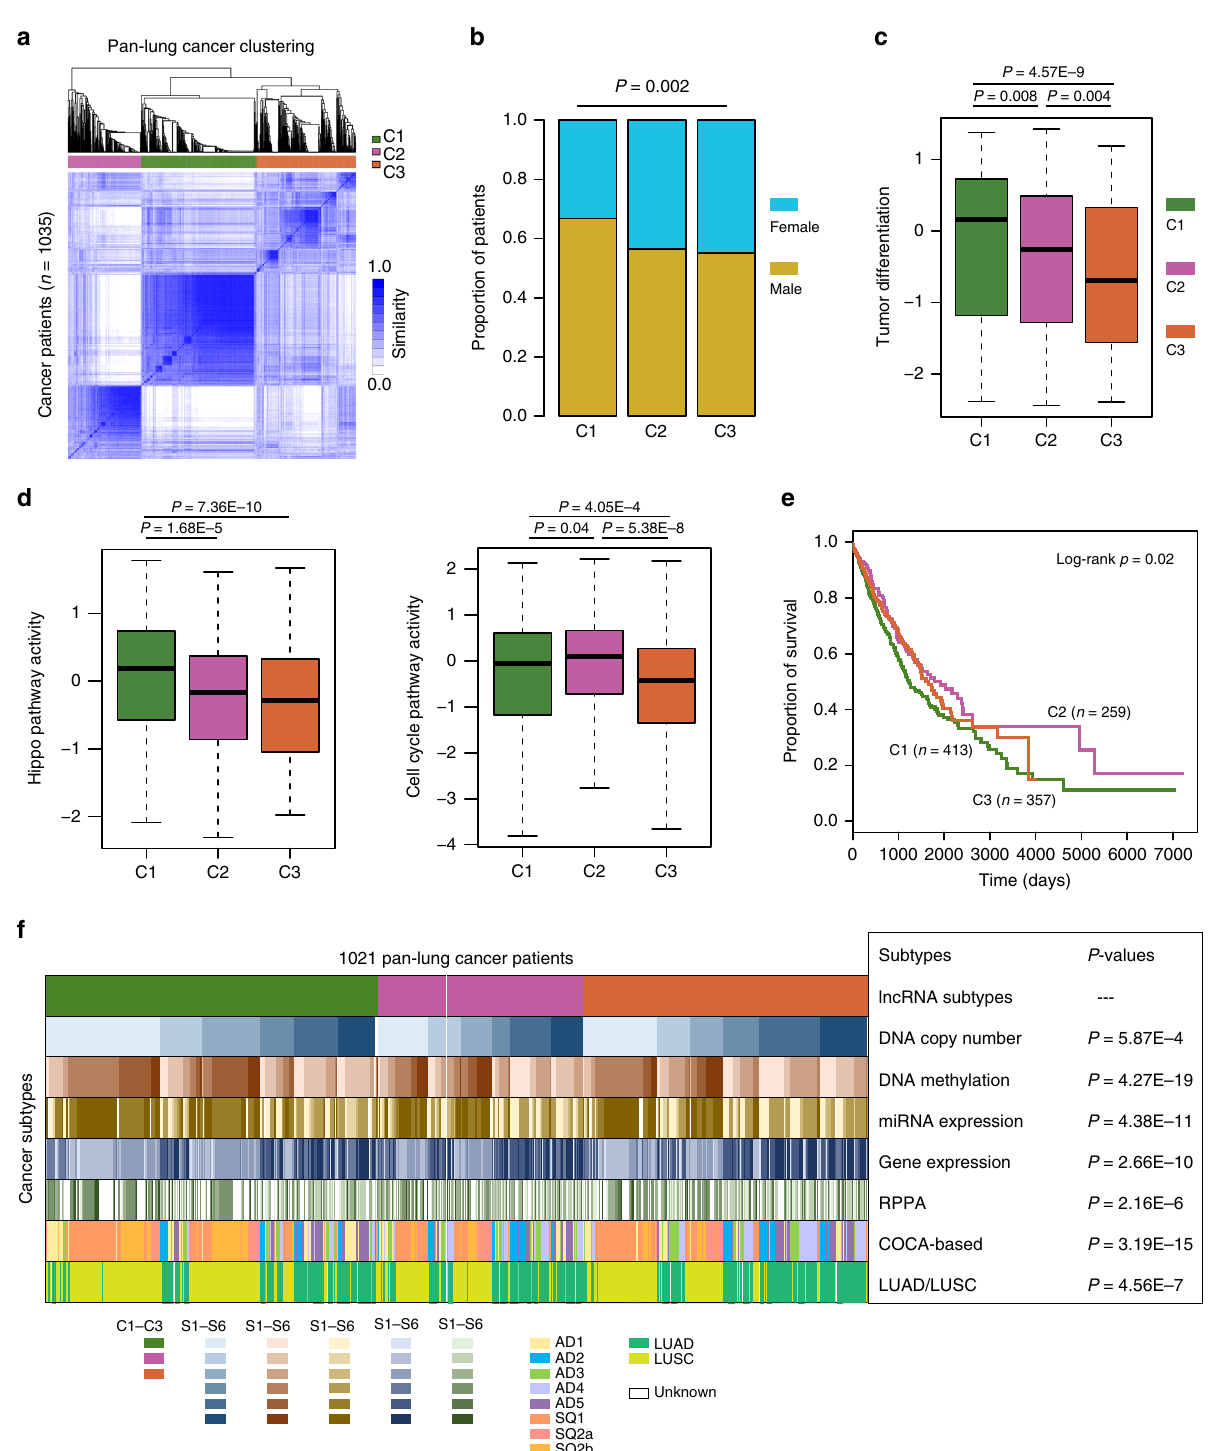
Fig. 5 Characterization of lung cancer subtypes. a Heat map of the matrix of co-occurrence proportions for cancer patients. b The proportion of male and female patients of different subtypes. n1 = 410, n2 = 257, and n3 = 356 biologically independent samples examined. P = 0.002, two-sided Fisher ’ s exact test. c The distribution of tumor differentiation scores for patients of different subtypes. n1 = 411, n2 = 253, and n3 = 357 biologically independent